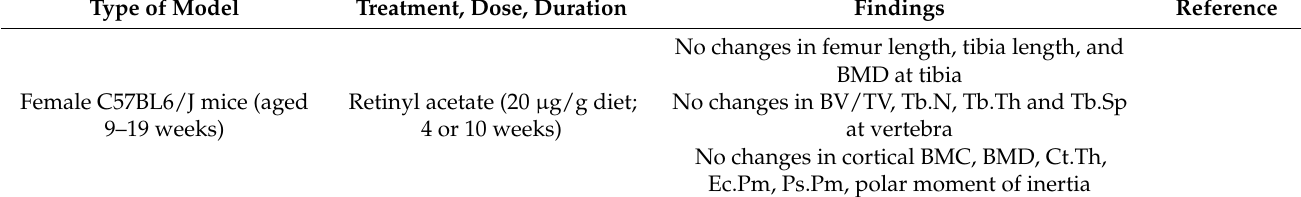
Table 1. Summary on the effects of vitamin A and provitamin A on bone health in animals. Type of Model Findings